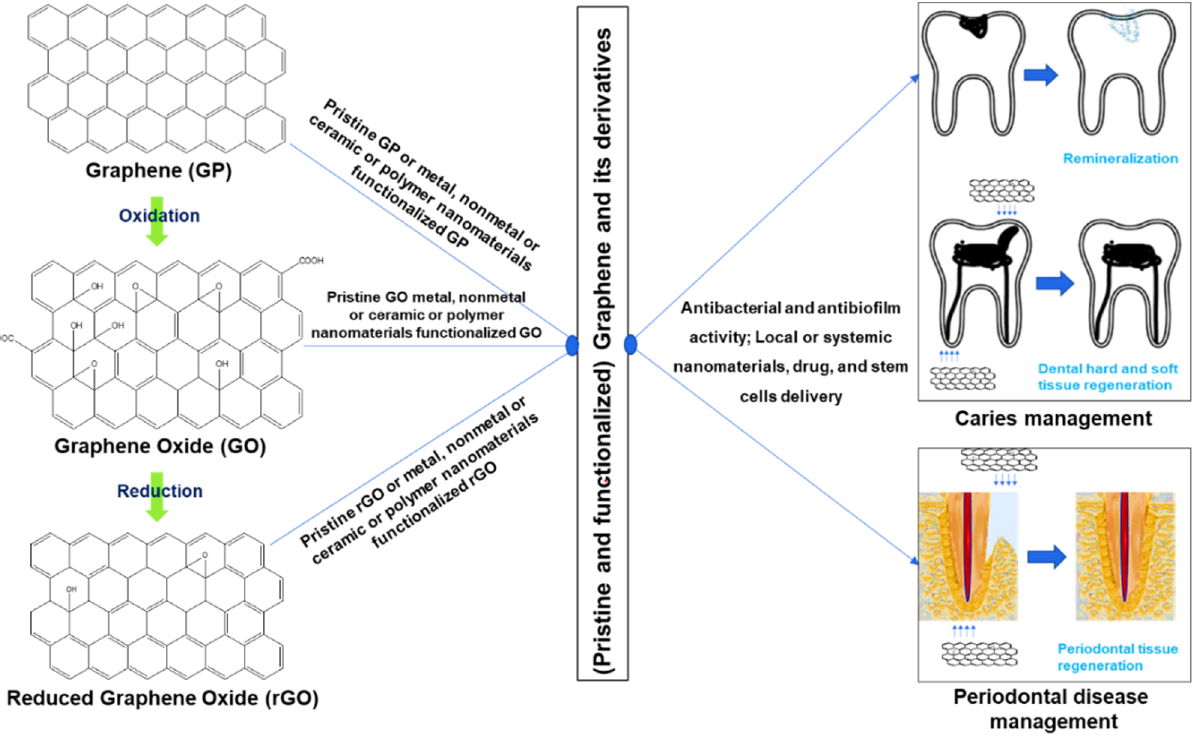
Figure 1. Use of graphene for management of dental caries and periodontal disease.